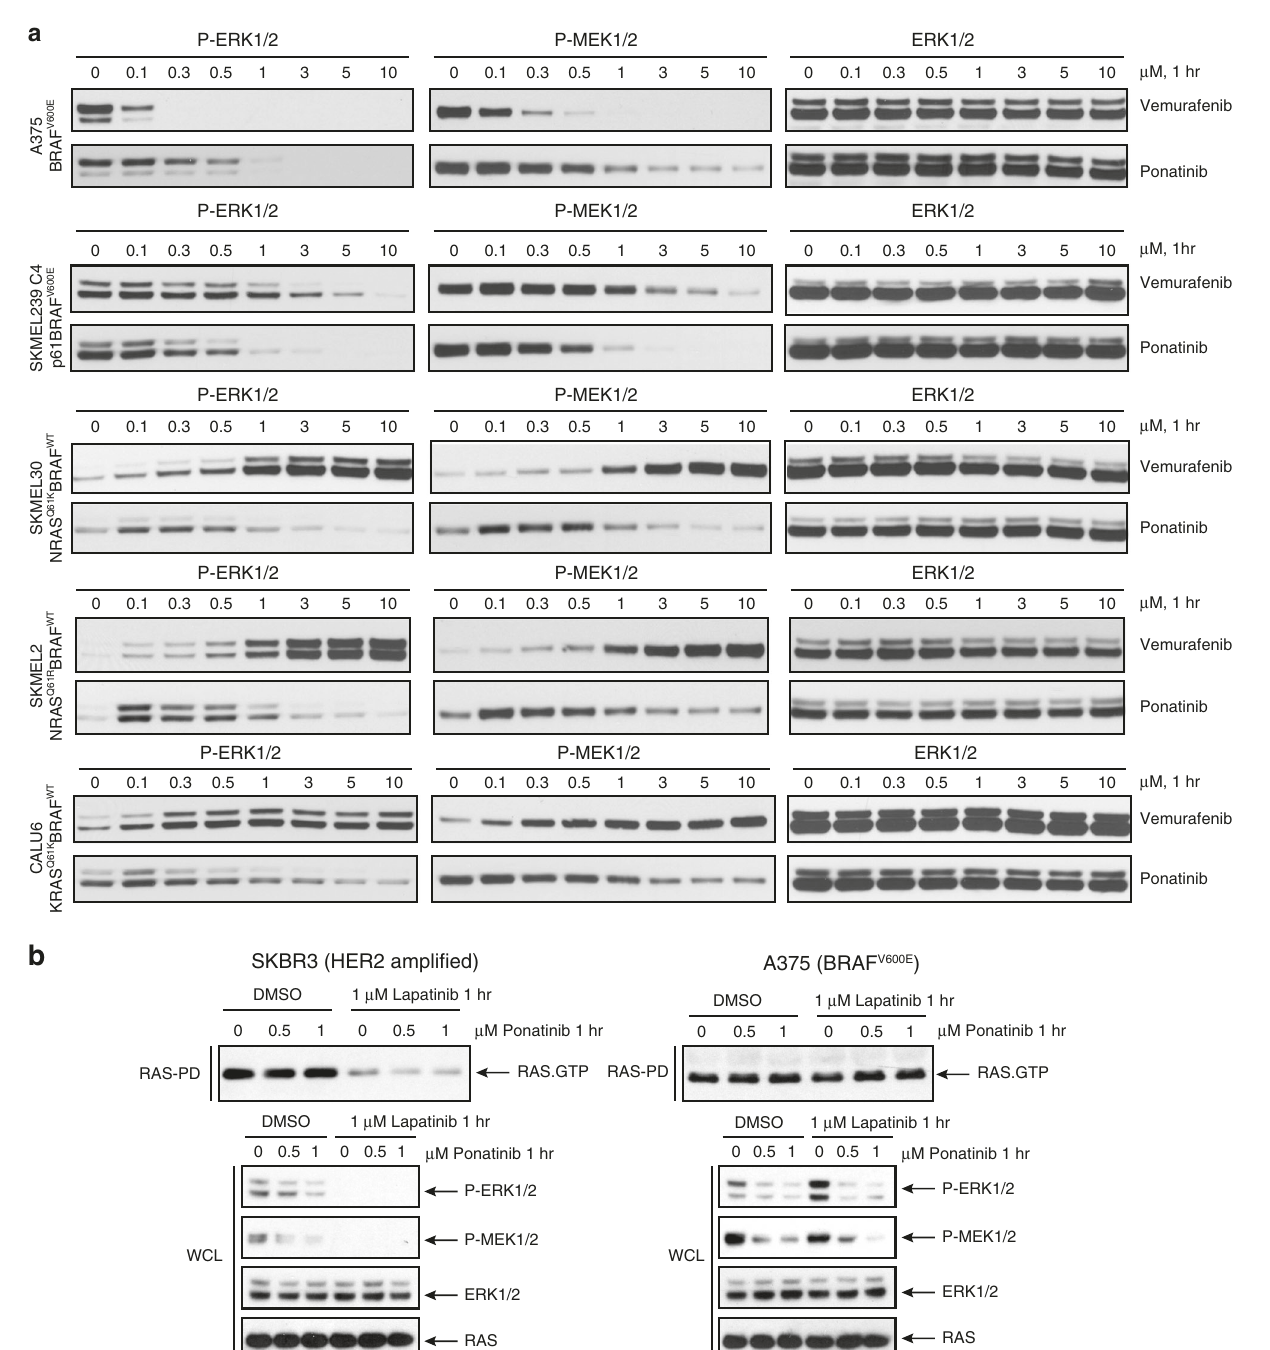
Fig. 4 Ponatinib inhibits different BRAF species and ERK signaling in cells. a Melanoma A375, SKMEL239-C4, SKMEL-30, SKMEL-2, and lung cancer CALU6 cell lines expressing BRAF V600E or RAS MUT /BRAF WT left untreated or treated with increasing concentration of Ponatinib or Vemurafenib for 1 h, then assayed for western blot and immunoblot with the indicated antibodies to probe ERK-signaling inhibition. Data are representative of three independent experiments. b Breast cancer SKBR3 cells, which are RTK-dependent HER2 ampli fi ed and melanoma A375 (BRAF V600E monomer) cells were left untreated or treated with increasing concentration of Ponatinib and Lapatinib, an EGFR/HER2 inhibitor, for 1 h, then assayed by immunoblot with the indicated antibodies. Data are representative of n = 3 independent experiments. Source data are provided as a Source Data fi ERK signaling and signi fi cantly reduced RAS WT -GST levels, as signaling by RTK inhibition in the absence of active BRAF or RAS-GTP mutations. Thus, we used SKBR3 breast cancer cell expected (Fig. 4b). To test whether Ponatinib affects RAS WT -GTP levels in an RTK-independent manner, we used A375 cells. Both line, in which HER2-activated RAS WT -GTP levels are attenuated by Lapatinib (dual EGFR/HER2 tyrosine kinase inhibitor) Ponatinib and Lapatinib did not reduce RAS WT -GTP levels, however Ponatinib only inhibited ERK signaling suggesting direct treatment 11 . Ponatinib inhibited ERK signaling without reducing RAS WT -GST levels in SKBR3 cells, whereas Lapatinib inhibited inhibition of BRAF V600E (Fig. 4b). We also con fi rmed BRAF